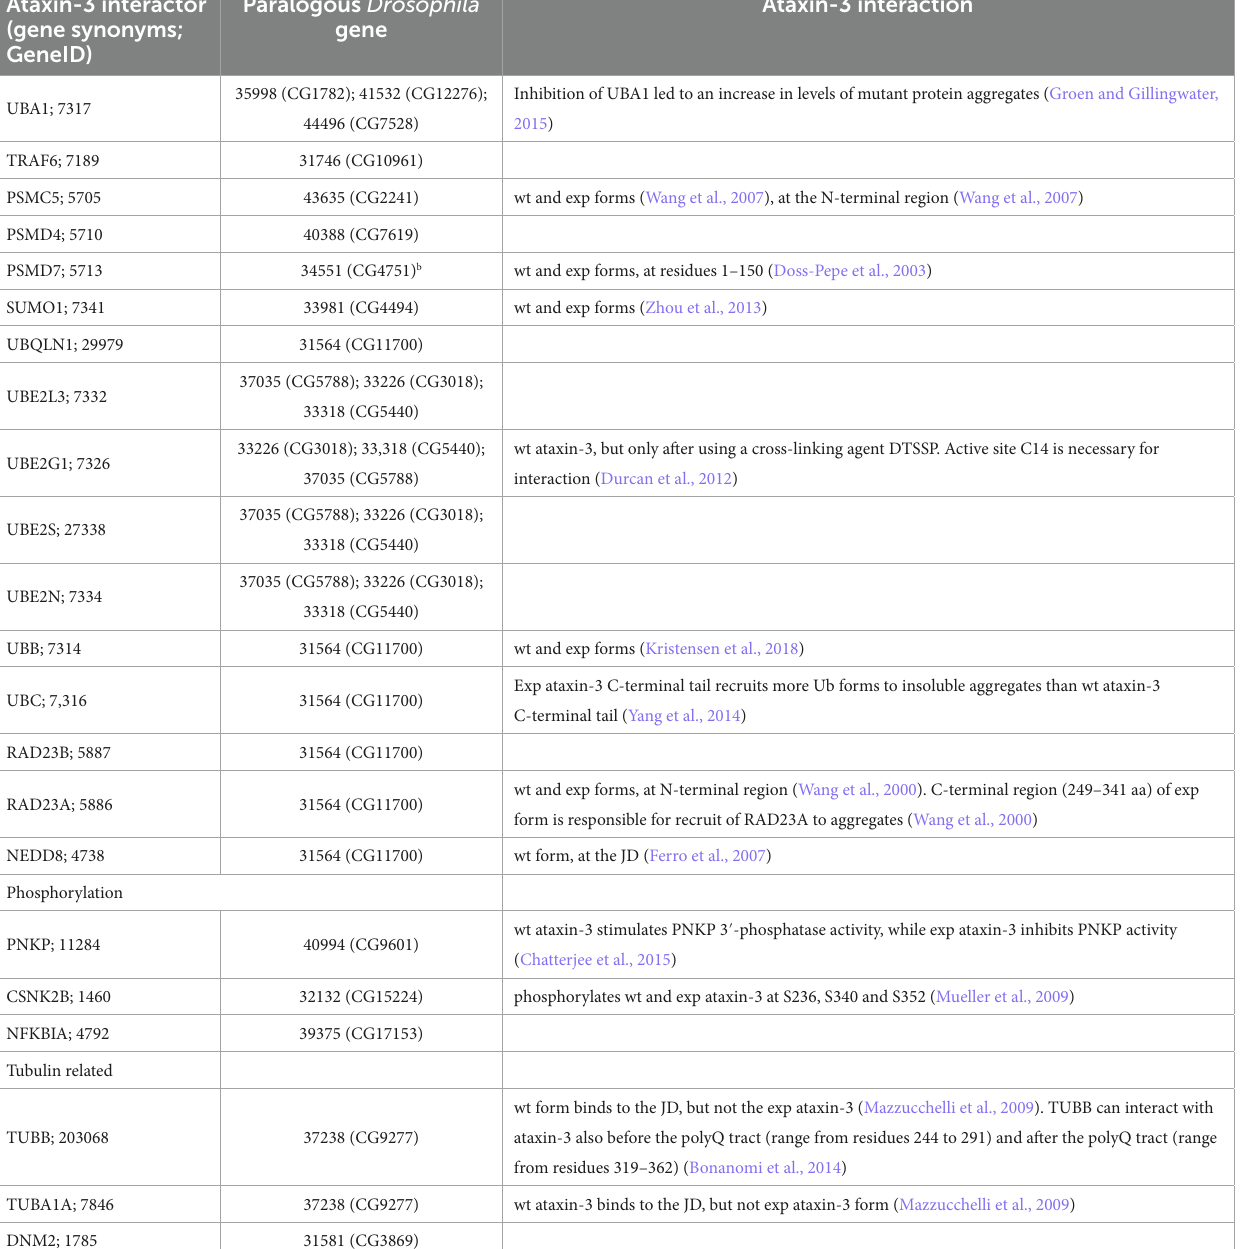
region, and five at the C-terminal ataxin-3 region (Figure 2A lower panel). The two interaction recognition regions overlap only at the end of the JD and surrounding region (Figures 2A–C for an example of each PPI binding type). Therefore, this region may be crucial for ataxin-3 interaction. The same interaction patterns are observed when considering the binding of fly proteins with human ataxin-3 (Figures 3A,B). For the proteins that interact mostly at the JD we find a significant correlation (Pearson’s correlation coefficient R = 0.9763; p < 0 0.00001; y = 1.0222x + 0.1672, being x and y the occupancy frequency of each ataxin-3 residue, in Drosophila and Homo , respectively; Figure 3A) between usage (in percentage) of an amino